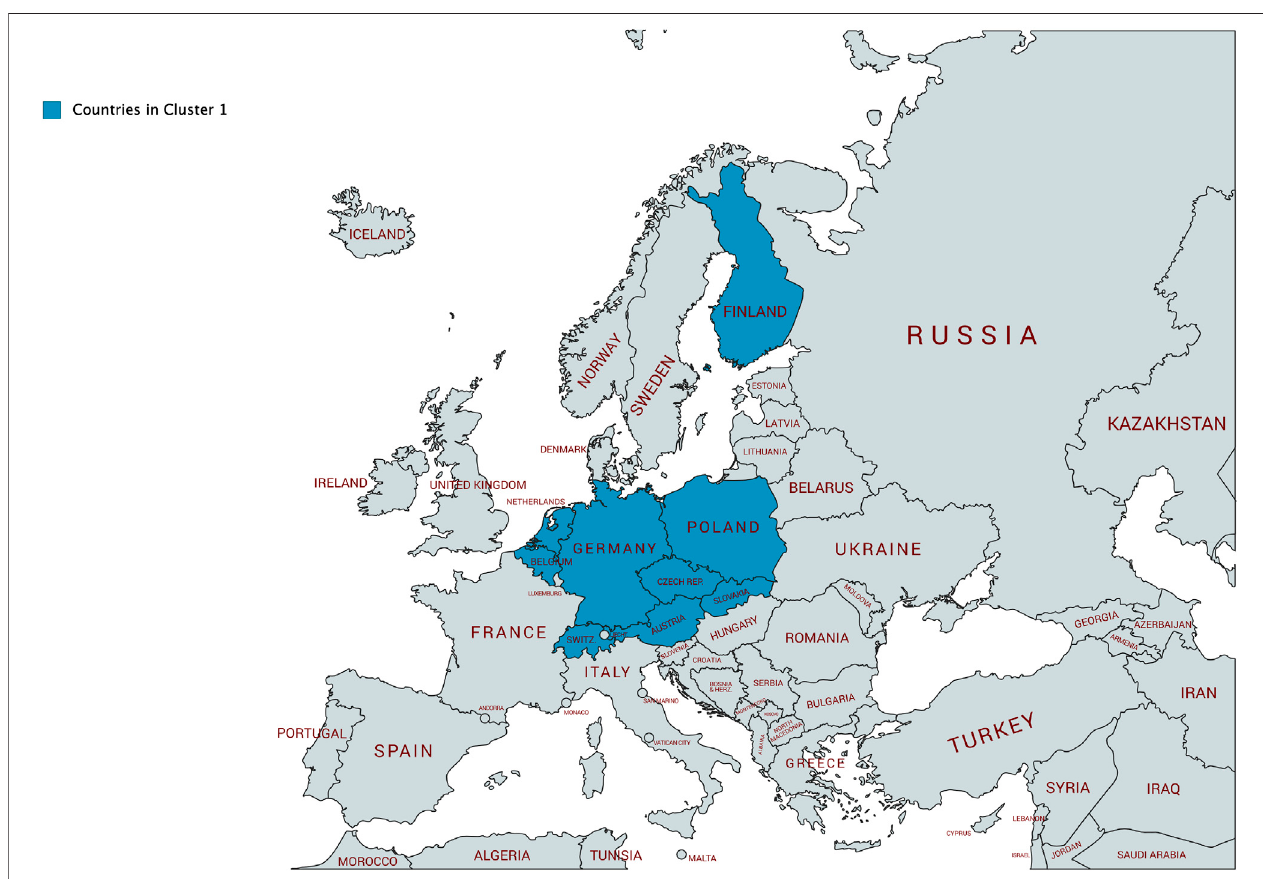
FIGURE 9 | Countries in Cluster 1 on a